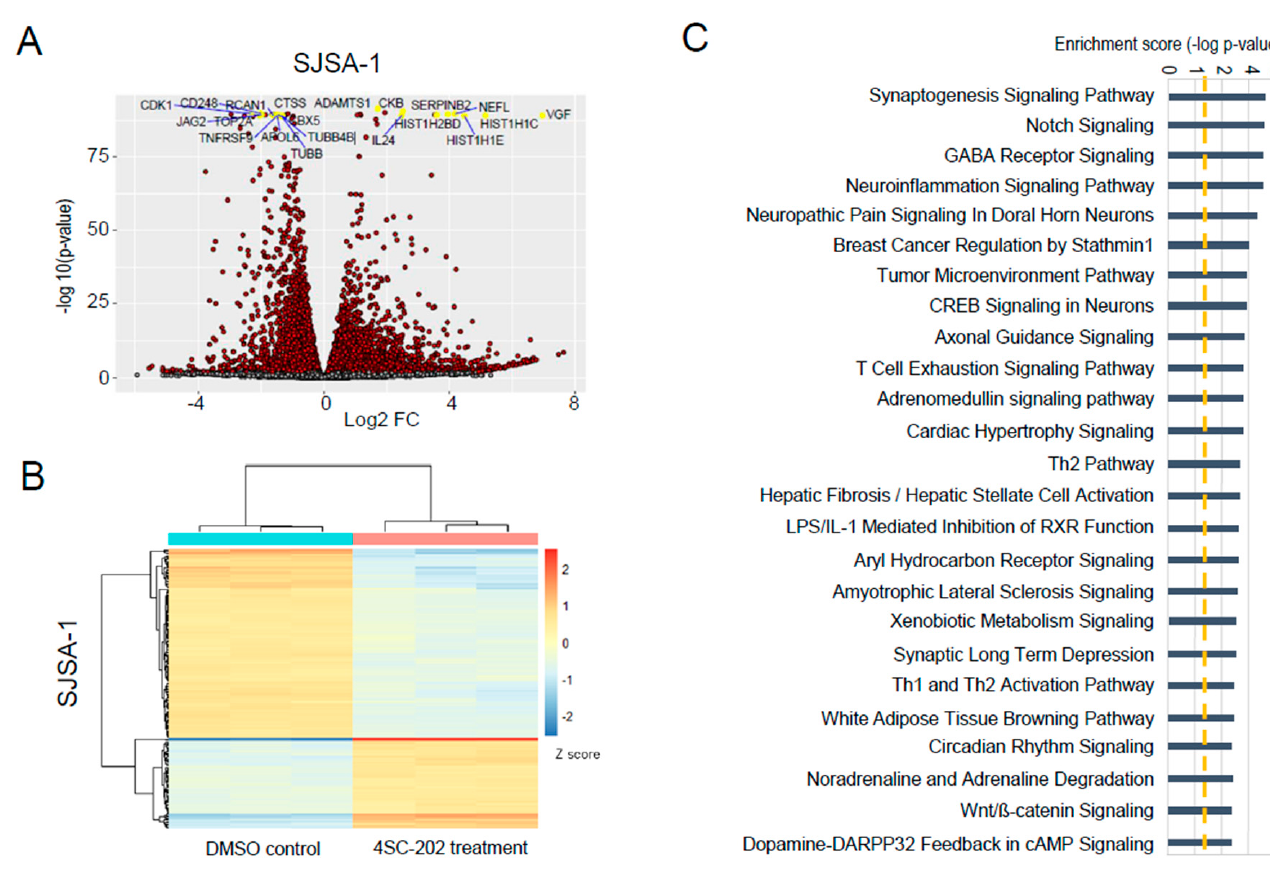
Figure 7. Differentially expressed genes and pathways in human OS cells. ( A ) A volcano plot of gene expression from RNA-seq analysis between the vehicle control and 4SC-202-treated SJSA-1 OS cells. The top 20 significantly differentially expressed genes are labeled. ( B ) Unsupervised hierarchical cluster analysis and heatmap representation of differentially expressed genes in SJSA-1 cells treated with either 1 μ M 4SC-202 or DMSO for 24 h. Intensity of color indicates expression levels (red, high; blue, low). Each column indicates a distinct sample, and each row indicates an individual gene. ( C ) Ingenuity pathways analysis (IPA) of cancer canonical signaling pathways associated with significantly regulated genes ( p < 0.05) in 4SC-202-treated samples compared to the vehicle-treated samples.